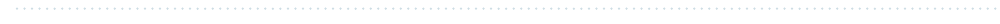
Figure 4. Excess mortality in working age populations in Bulgaria and other European countries in 2020. ( A ) P-scores for the overall population in ages 30–39; ( B ) P-scores for females in ages 30–39; ( C ) P-scores for males in ages 30–39; ( D ) P-scores for the overall population in ages 40–64; ( E ) P-scores for females in ages 40–64; ( F ) P-scores for males in ages